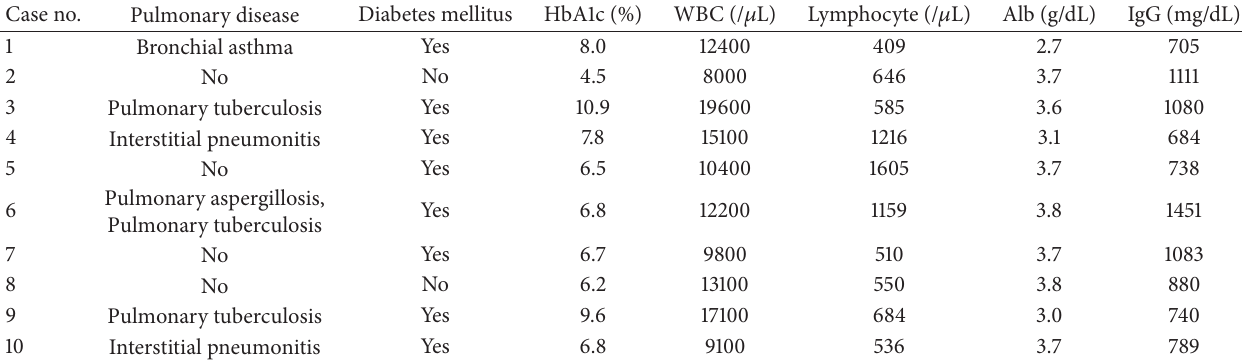
Table 2: Comorbidities and clinical data of rheumatic disease patients with Nocardia infection. Case